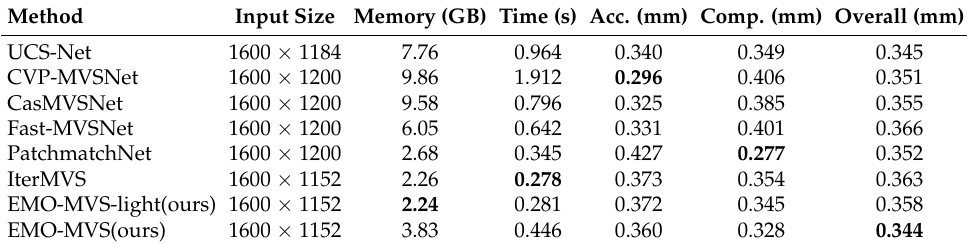
Table 2. Comparison of memory consumption and runtime on DTU evaluation dataset ( ↓ ) [46]. Bold font represents the